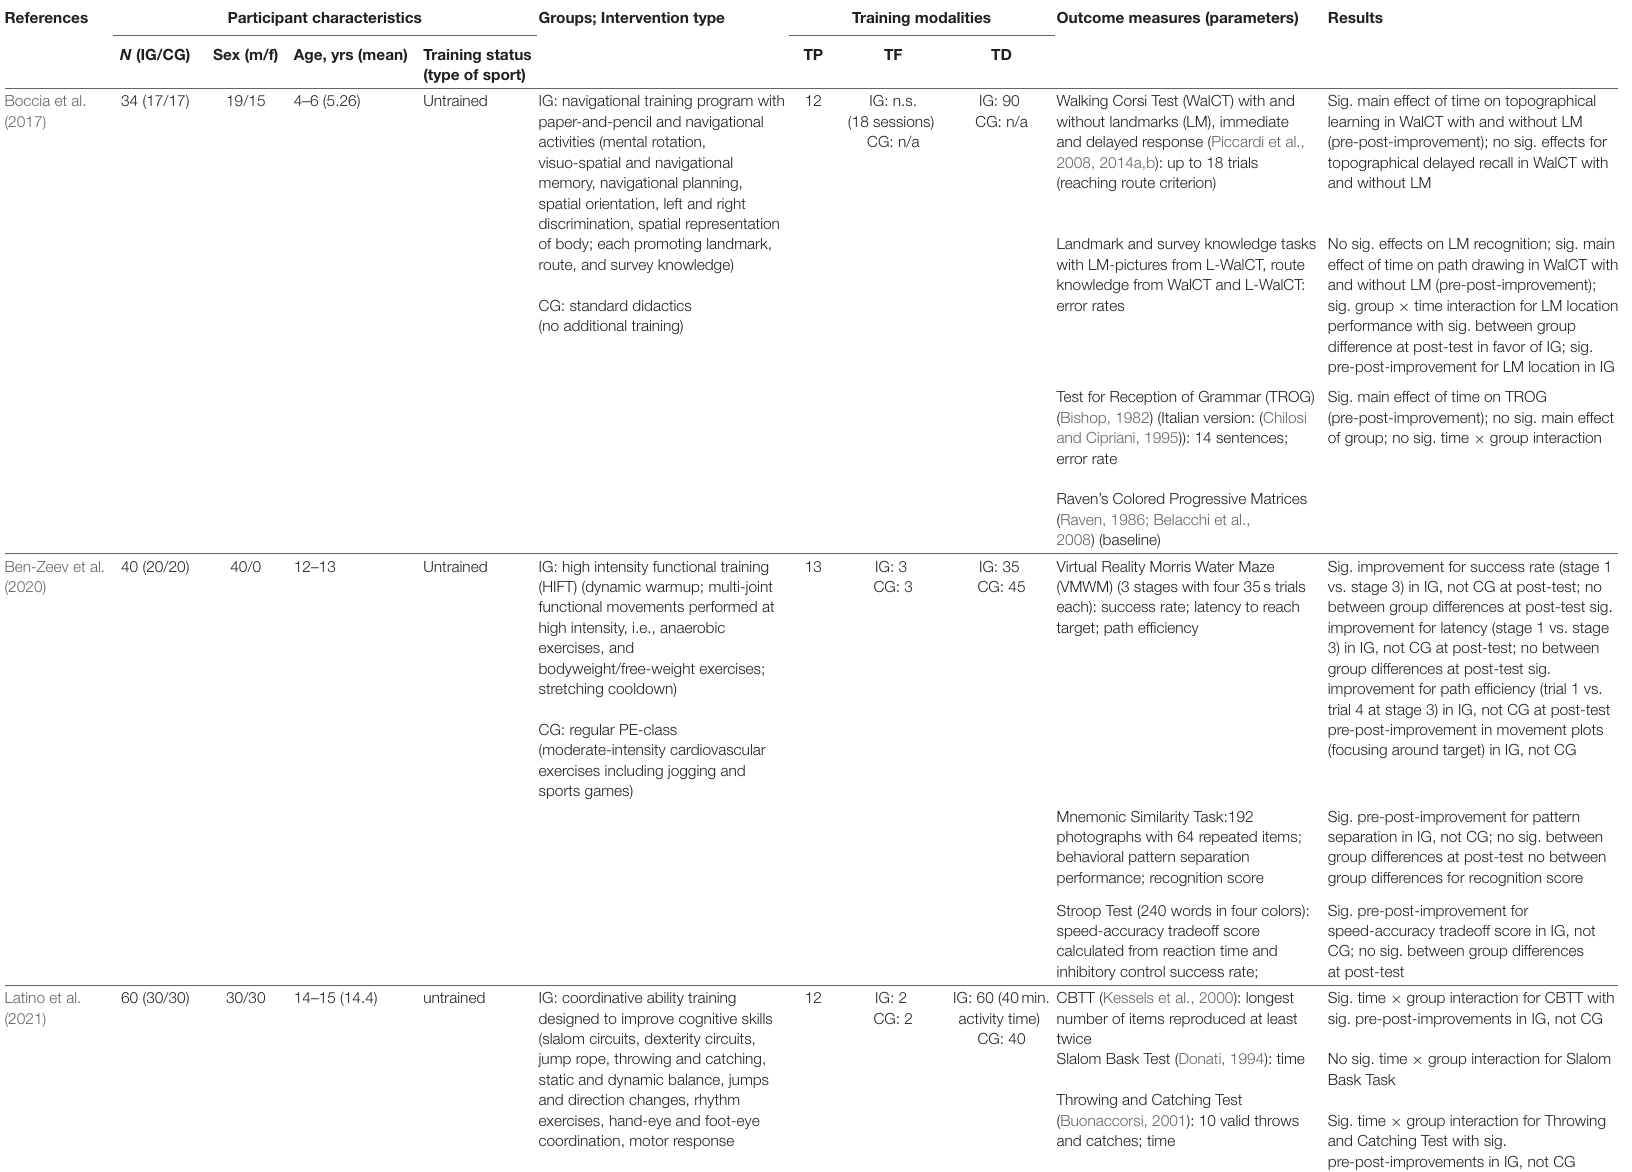
12 Sig. time × group interaction for CBTT with